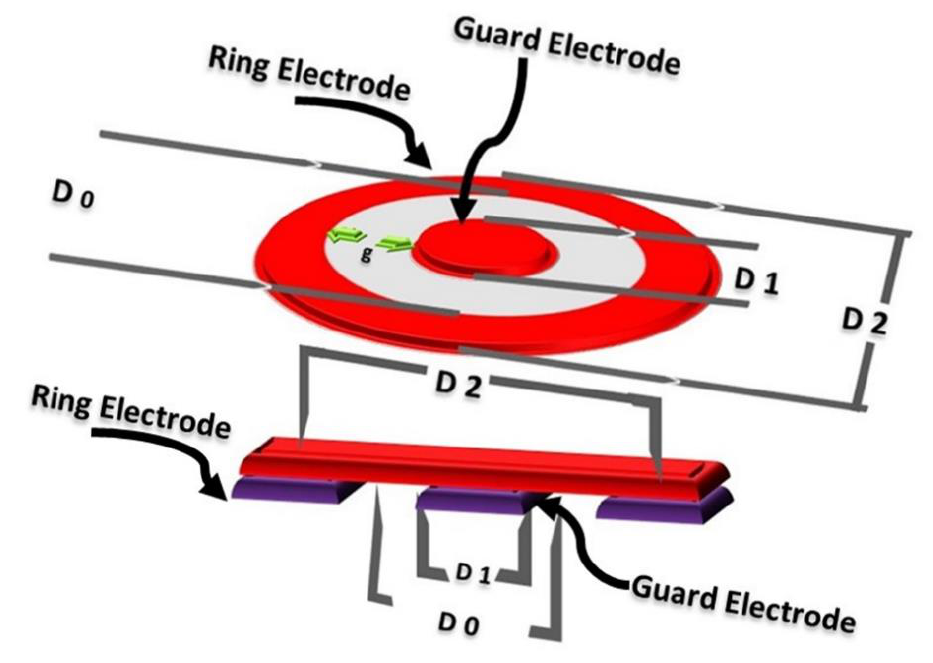
Figure 2. Setup for electrical conductivity test.